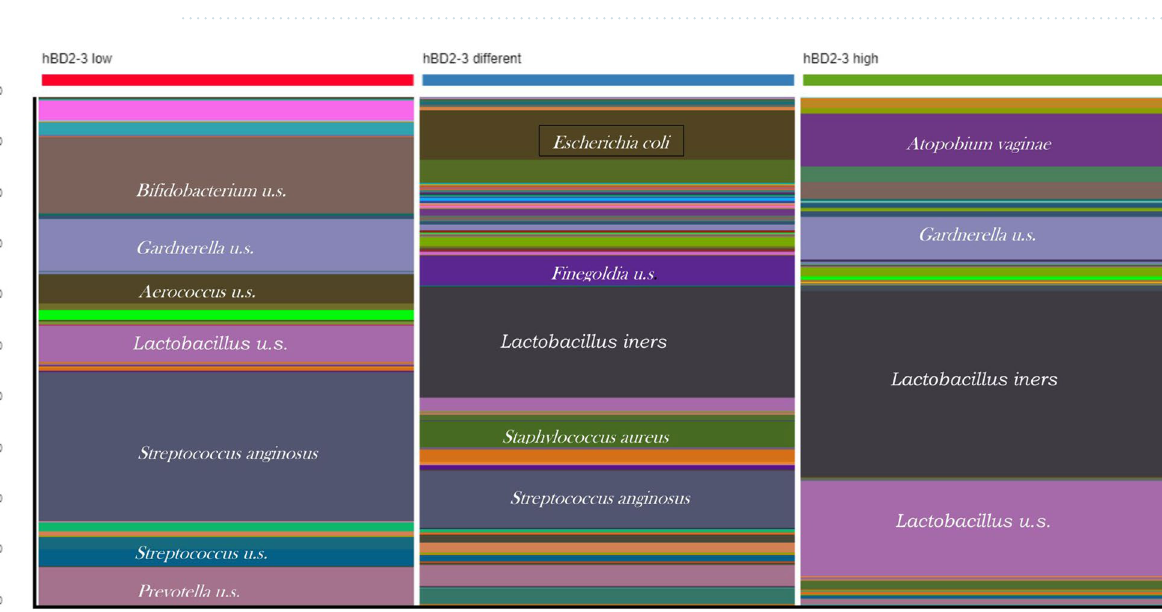
Figure 4. Heatmap visualization of the 35 most abundant taxa at species level among the LS patients. L. iners is associated mainly with Lactobacillus u.s . and Pediococcus acidilactici. S. anginosus had frequent coexistence only with other Streptococcus sps , or Corynebacterium u.s . In the further polymicrobial samples the most abundant species were Gardnerella u.s., Bifidobacterium u.s . and Atopobium vaginae .